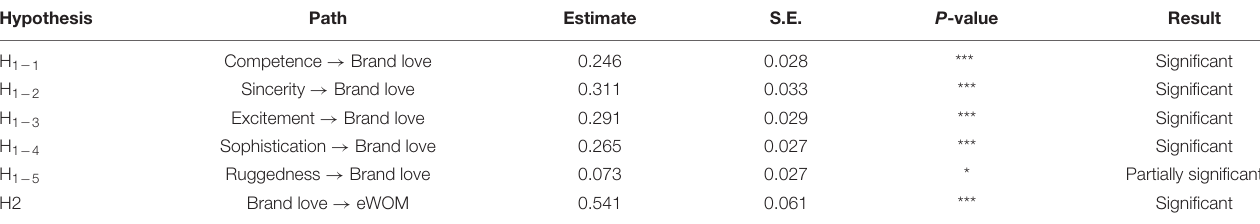
TABLE 5 | SEM empirical